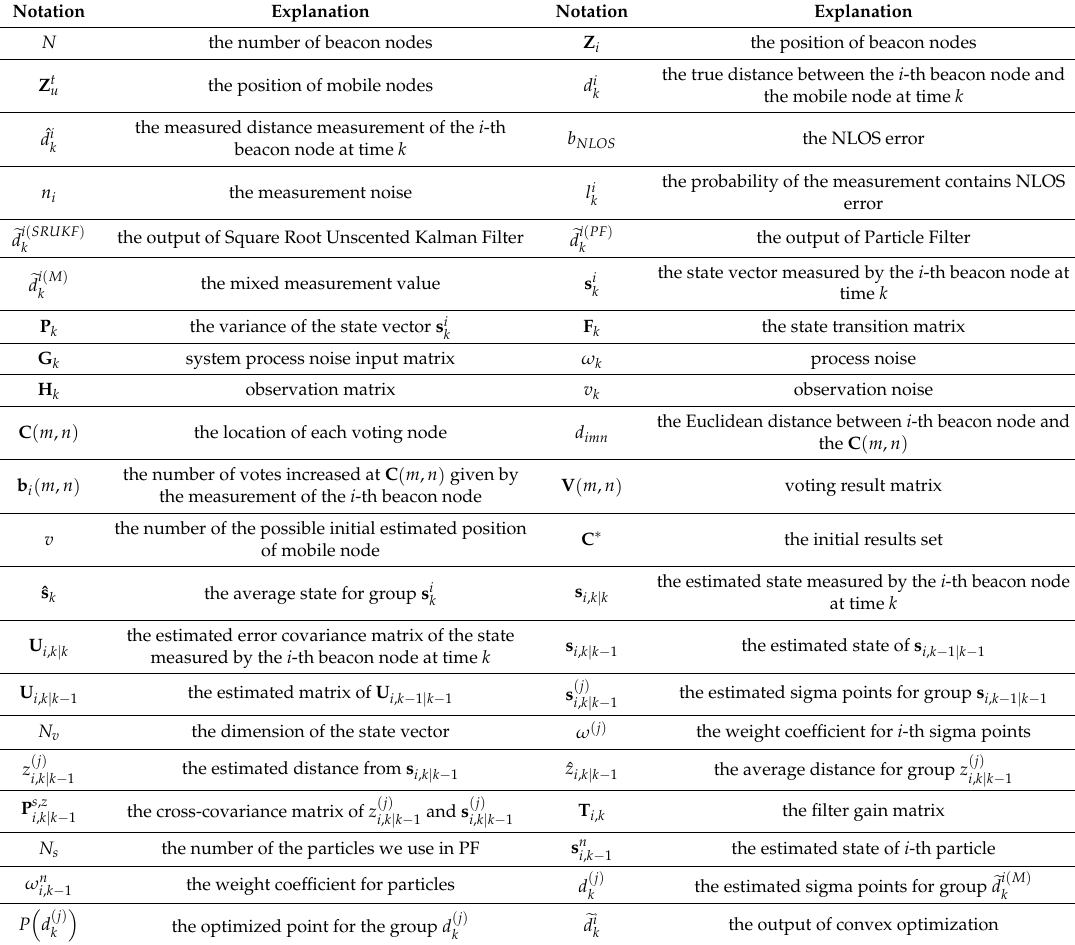
Table 1. List of Key